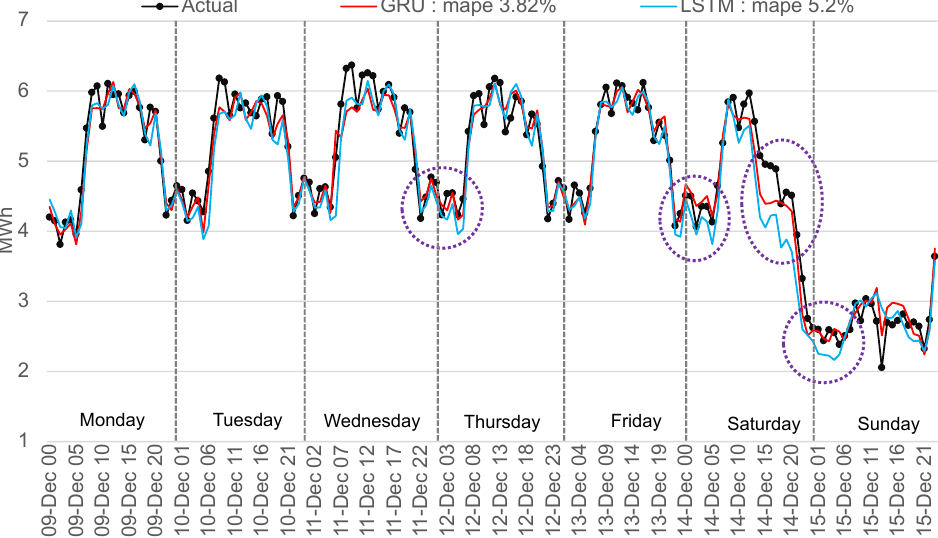
Figure 20. Comparison of actual with forecasted consumption—GRU and LSTM. The best-obtained result with a GRU network uses 20 inputs (past 14 days of hourly data, day of the week, working/non-working day and hours, special days, and tempera- ture). The structure of the network comprises three hidden layers (200, 200, 168) trained for 100 epochs using the Adam optimizer for the gradient descent [69] and all the ML algorithms implemented mean square error for the loss function. The LSTM network that obtained the result presented in Figure 20 has the same structure as the GRU